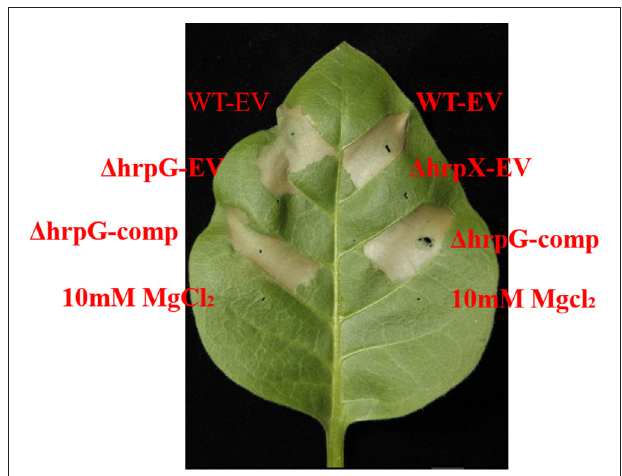
FIGURE 3 | Effects of hrpG and hrpX gene on Acidovorax citrulli inducing a hypersensitive response (HR) on Nicotiana tabacum. Loss of HR-inducing ability on N. tabacum by the hrpG and hrpX mutants. The wild-type Aac5 and mutant carrying empty pBBRNolac-4FLAG and complemented strains 1 hrpG-comp, 1 hrpX-comp were inoculated into the N. tabacum leaves at a concentration of OD 600 = 0.3 and incubated for 24h. Ten millimolars